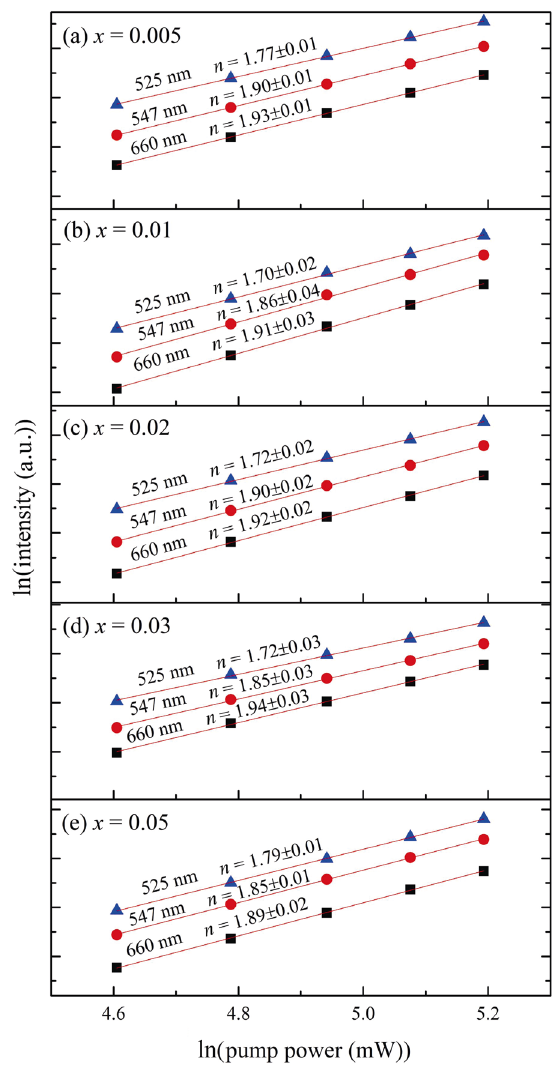
Fig. 10 Excitation power dependence of the two green and one red emissions in (a) x = 0.005, (b) x = 0.01, (c) x = 0.02, (d) x = 0.03, and (e) x = 0.05, annealed at 1200 ℃ .